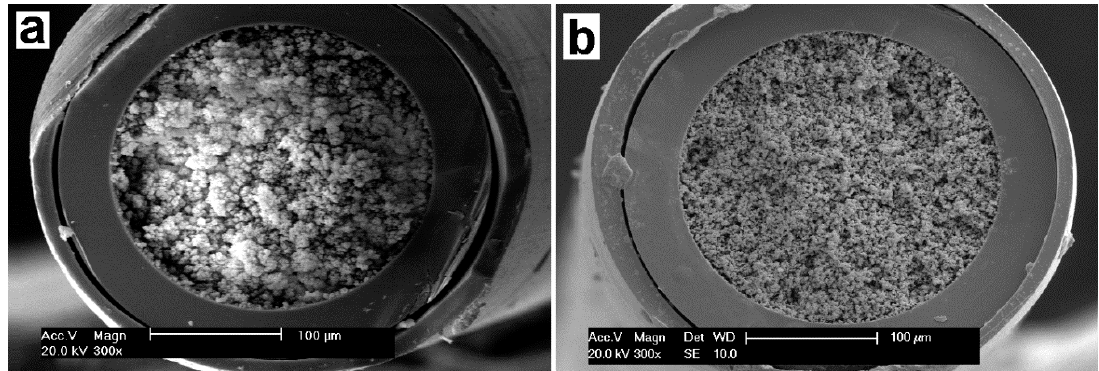
Figure 1. SEM images of ( a ) the poly (OMA-co-TRIM) monolithic column and ( b ) the poly (OMA-co-EDMA) monolithic column.